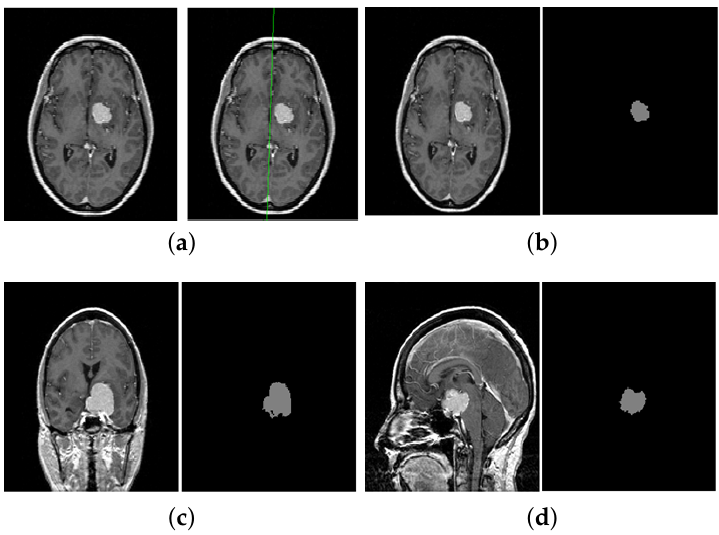
Figure 4. Illustration of some obtained results for brain tumor segmentation. ( a ) shows the step of symmetry axis detection. ( b – d ) show the final segmented region of interest (brain tumor) in different MR